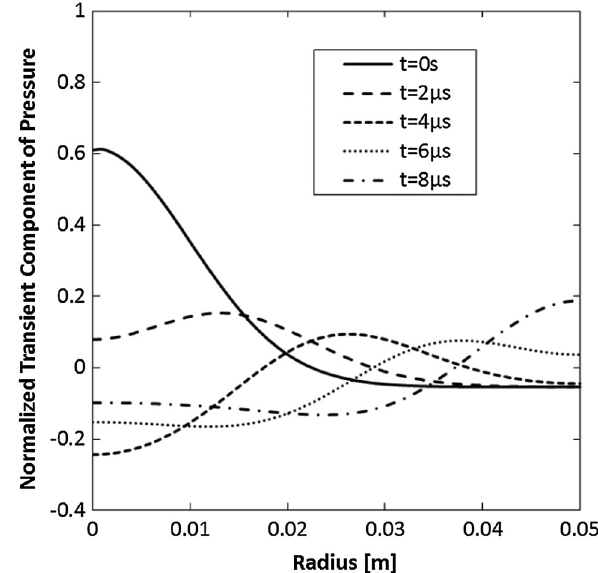
FIG. 9. Pressure wave components at t ¼ 2 μ s for the test case assuming plane